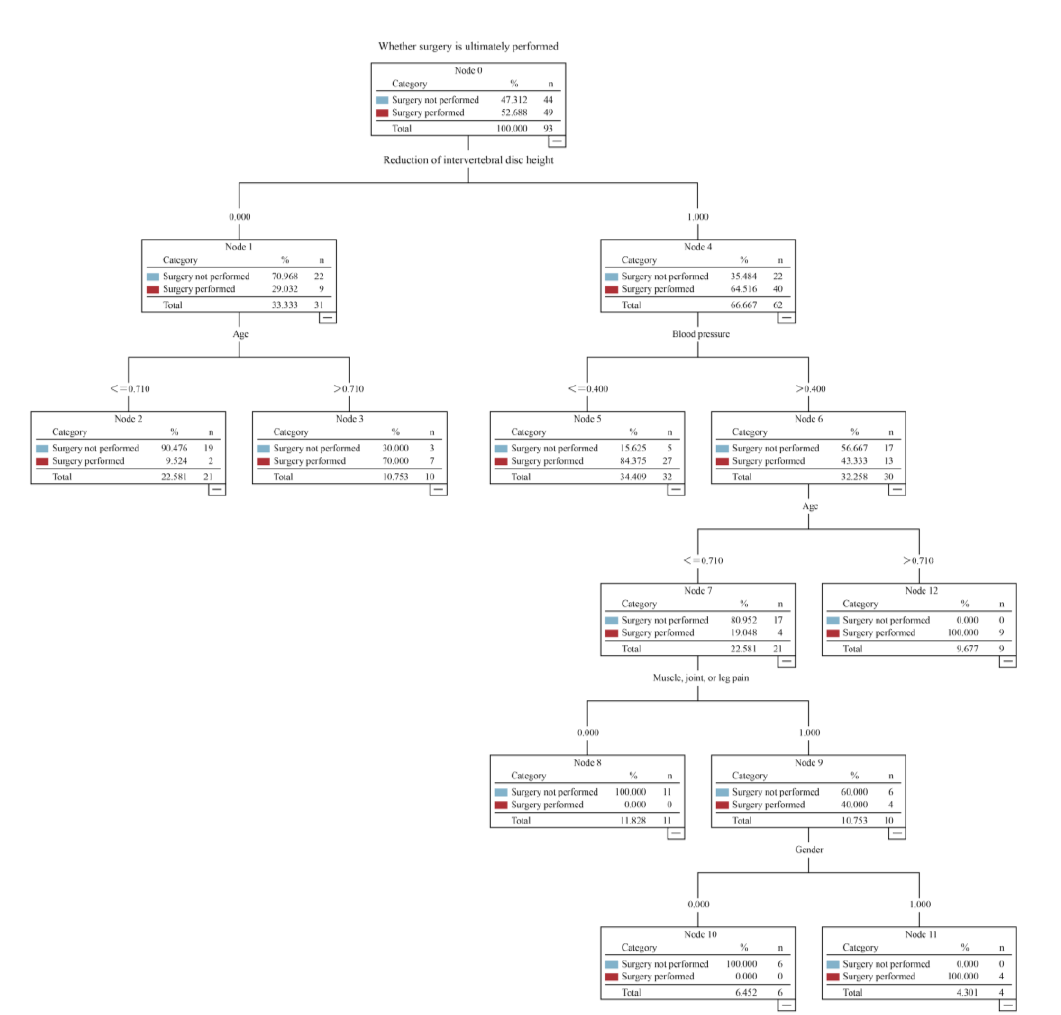
Figure 3. Rules extracted from the C5.0 DT (70% data for training and 30% for